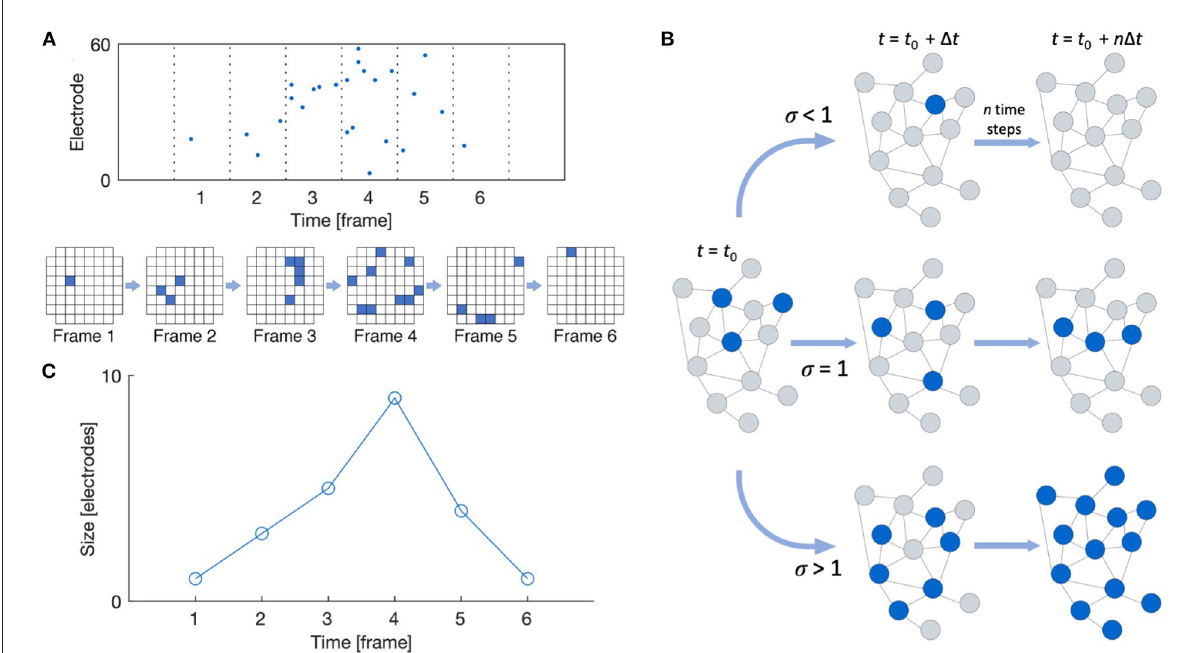
FIGURE2 Neuronal avalanche definitions. (A) Raster plot and schematic showing a typical MEA layout with active recording channels shown in blue. A neuronal avalanche is defined as a sequence of active time frames bounded before and after by empty frames. (B) The branching ratio is defined as the ratio of descendants to ancestors. (C) The avalanche shape is defined as the size of the avalanche as a function of time. Reproduced from Heiney et al.